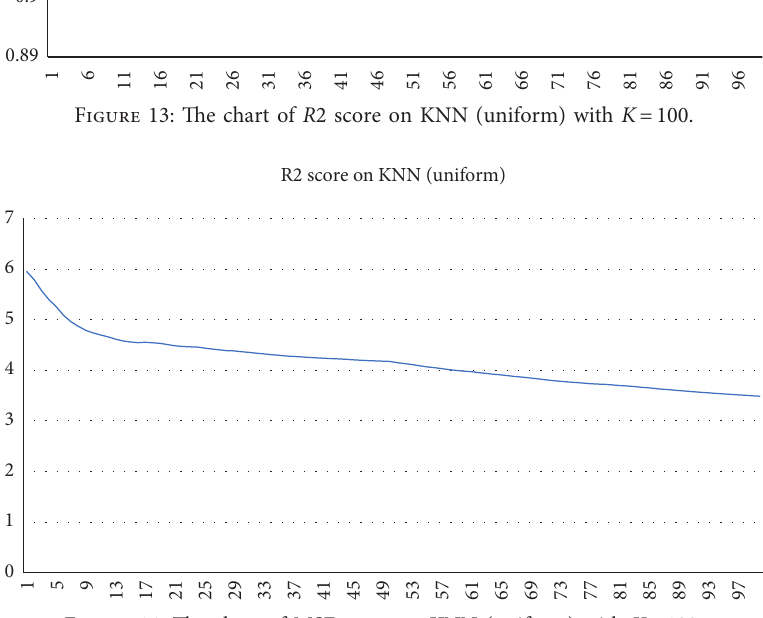
Figure 14: The chart of MSE score on KNN (uniform) with K � 100. Table 8: The normalized MSE value in Table 7: Testing result of SVM on RSS.